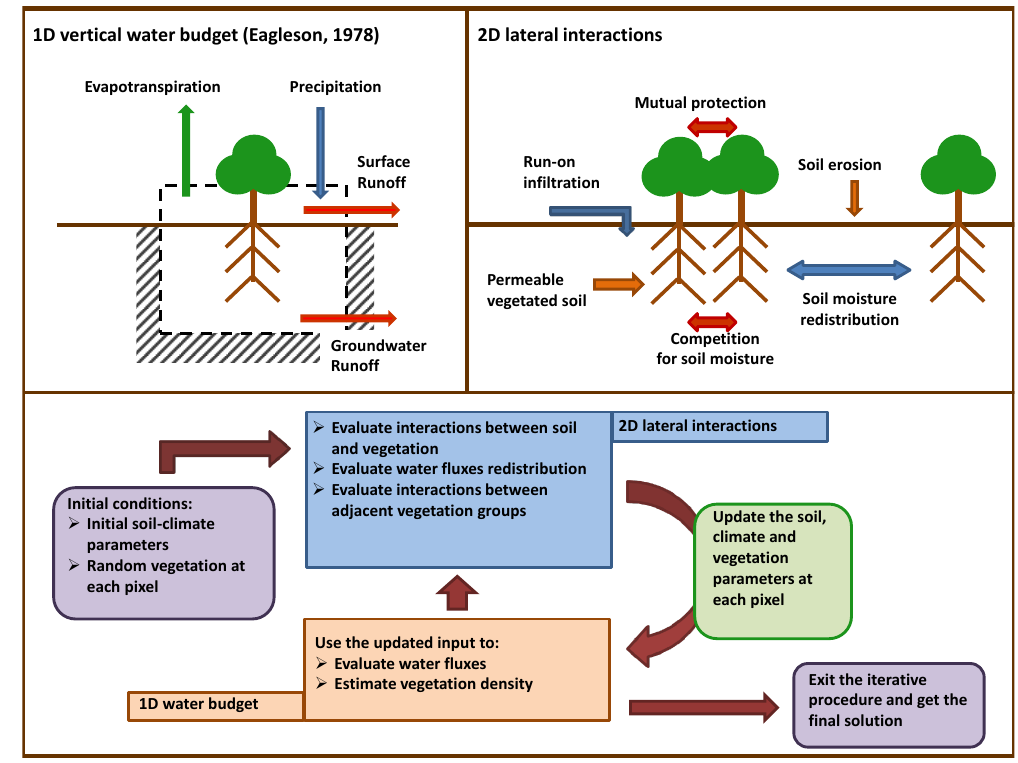
Fig. 2. Schematic of the 1-D vertical budget model and the 2-D lateral interactions with flowchart of the simulation procedure of the soil– climate–vegetation